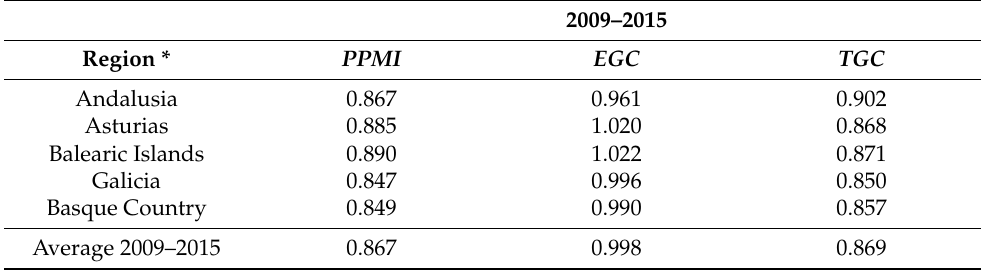
Table 7. Pseudo-panel Malmquist index for productivity and its decomposition.